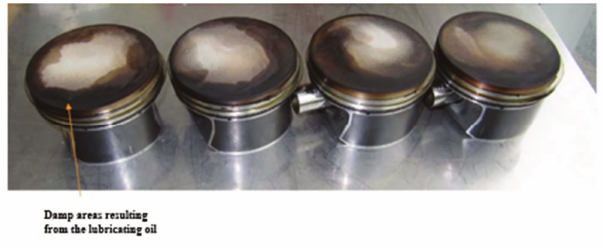
Fig. 8. State of the catalytic surface after 28 hours of operation